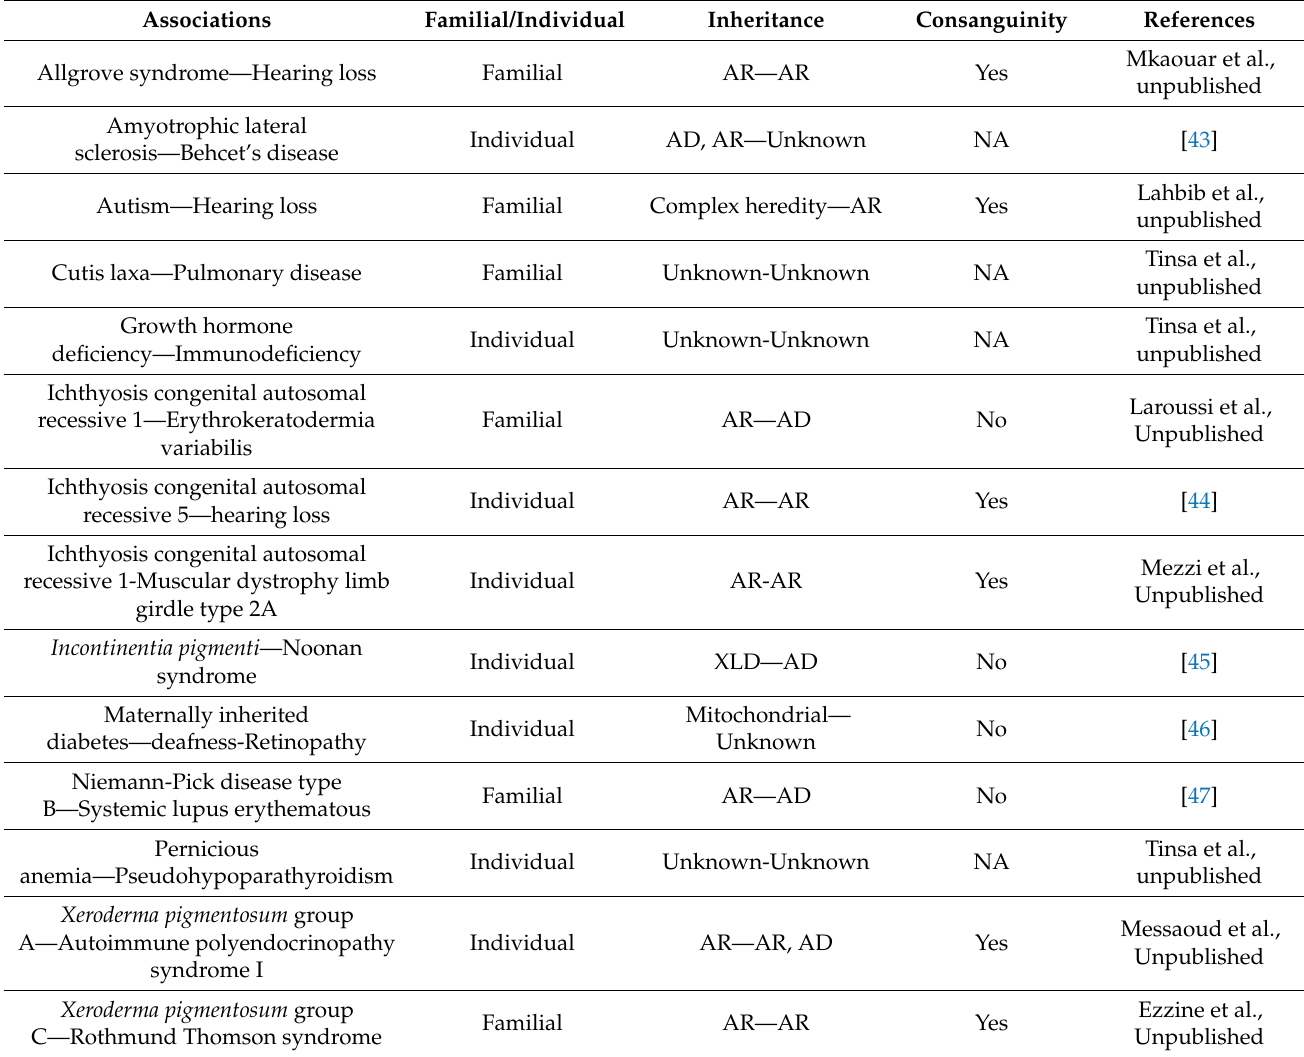
Table 2. Comorbid associations described among Tunisians between 2016 and